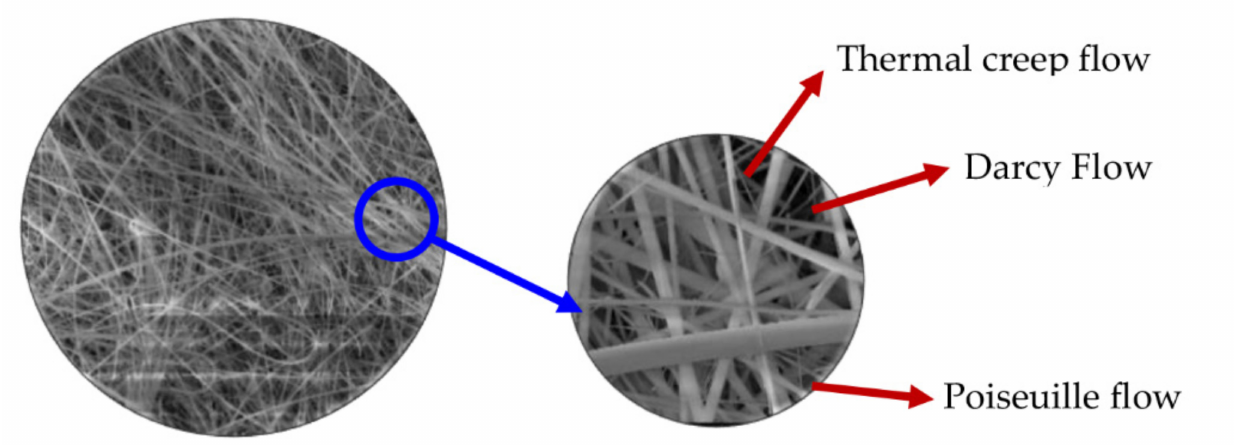
Figure 2. Microscopic picture of borosilicate glass filter from scanning electron microscope (SEM) (Locations of thermal creep flow, Darcy flow and Poiseuille flow are only to demonstrate that different locations have different flow